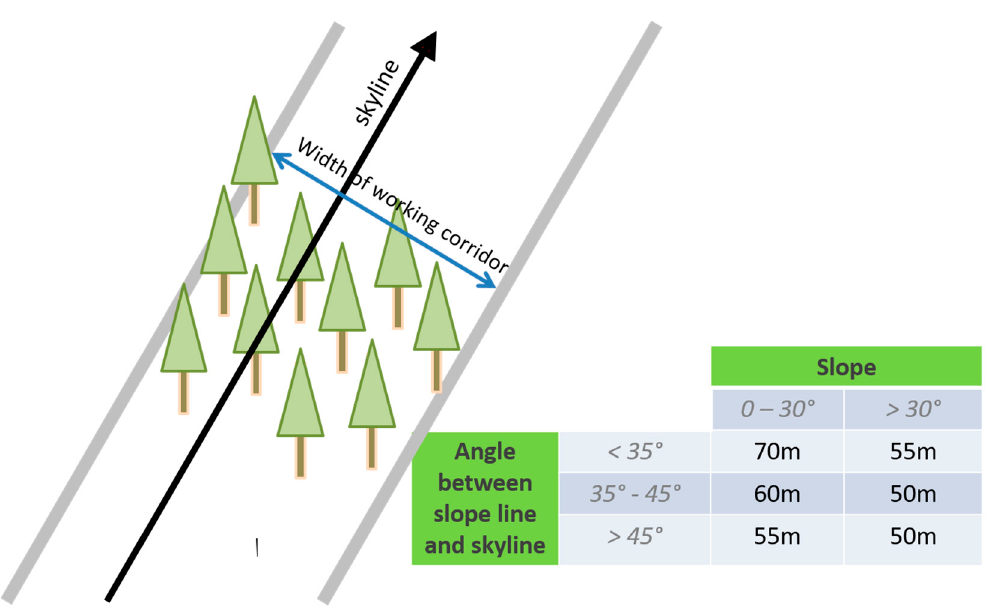
Figure 3. Width of the working corridor within a CR, depending on the slope and the angle between slope line and